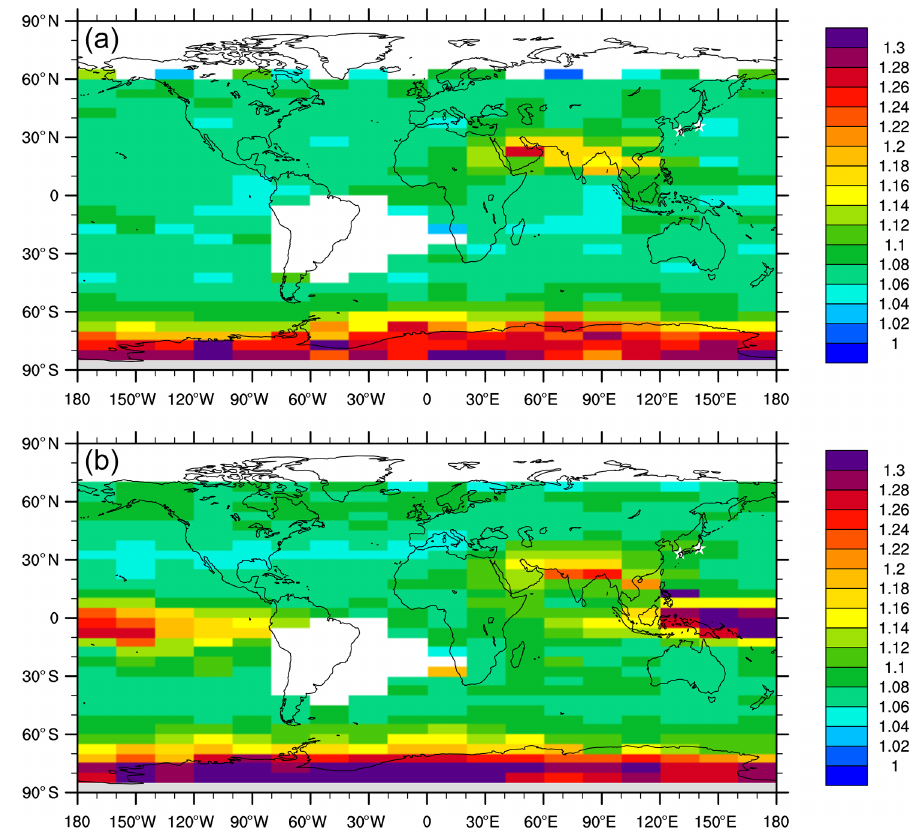
Figure 10. Monthly mean horizontal distribution of attenuated scattering ratio at 17.042km observed with the CALIOP satellite instrument in (a) July 2018 and (b) August 2018. Spatial bins are 5 ◦ in latitude, 20 ◦ in longitude, and 900m in altitude. Clouds and PSCs have been removed (Sect. 2.2). It is noted that the CALIOP attenuated scattering ratio is defined as the ratio of the measured attenuated backscatter coefficients and the attenuated backscatter coefficients calculated from the molecular model, and its valid range is from 0.60 to 25.00. The two lidar station locations are marked with white stars. White regions indicate missing measurements (see Noel et al., 2014, for the data missing over the South Atlantic